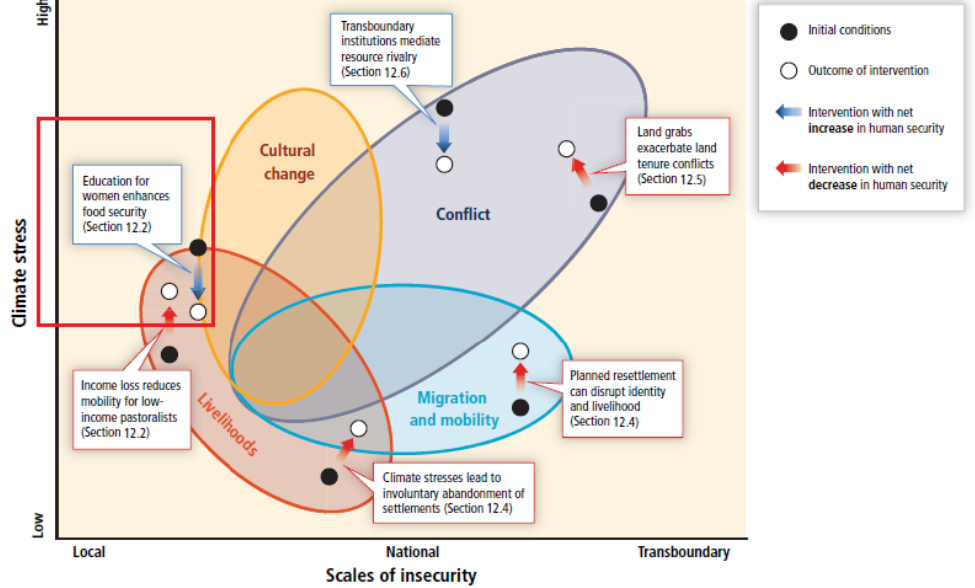
Figure 5. Women ’ s education strengthens livelihoods and promotes cultural changes [22]. Figure 5. Women’s education strengthens livelihoods and promotes cultural changes